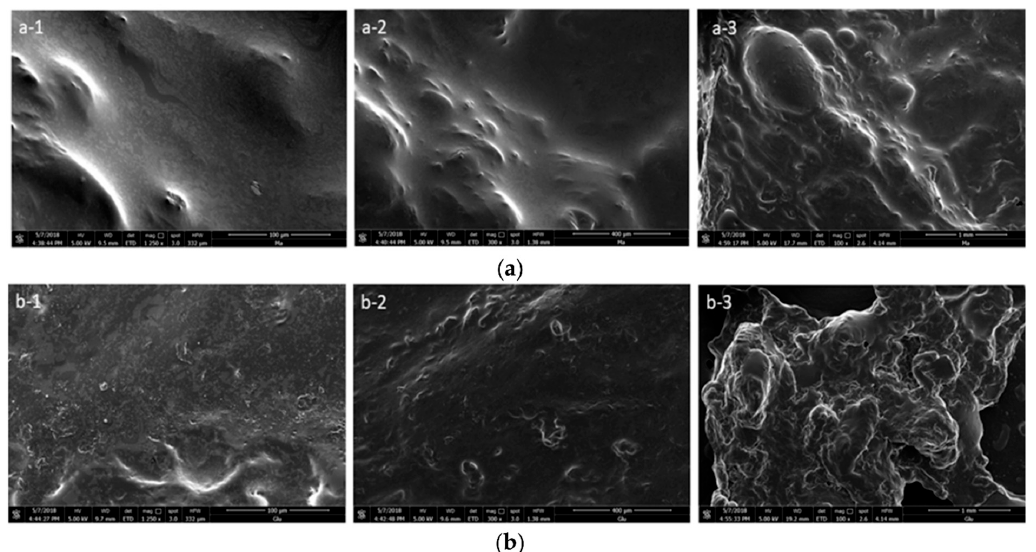
Figure 9. ( a ) Electron images of pectin extracted by [Ch]Cl–malonic acid; ( a-1 ) (1250 × ), ( a-2 ) (300 × ) ( a-3 ) (100 × ) and ( b ) electron images of pectin extracted by [Ch]Cl:glucose–water; ( b-1 ) (1250 × ), ( b-2 ) (300 × ) ( b-3 ) (100 × ). Reproduced from [249]. 6.